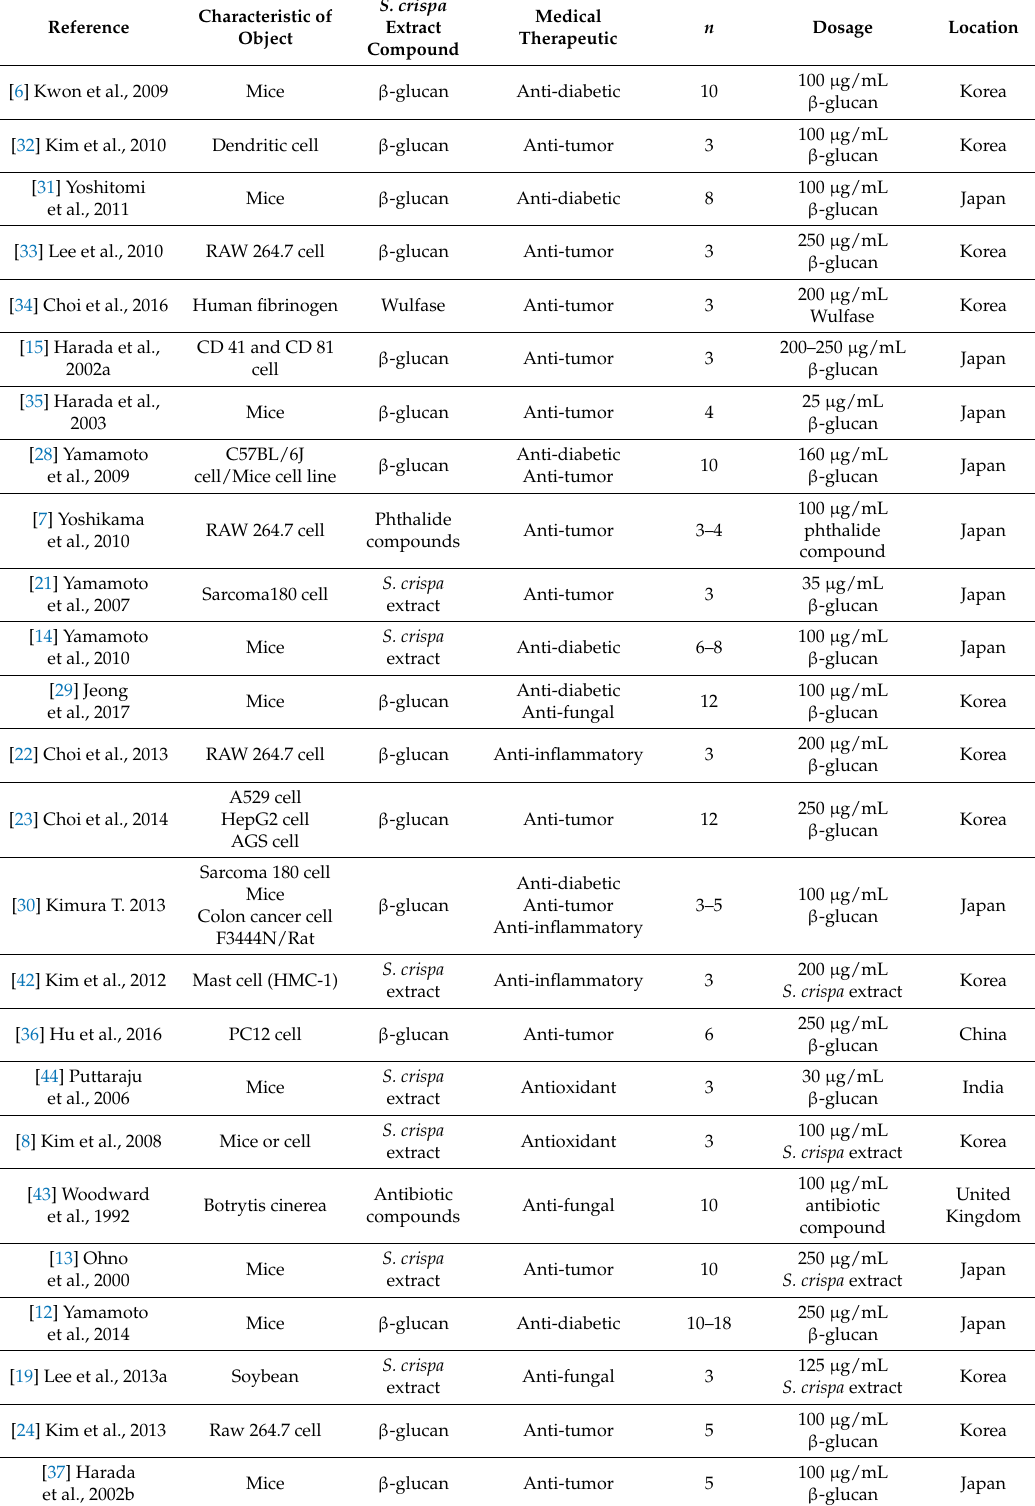
Table 1. Summary of the characteristics of the studies included in this